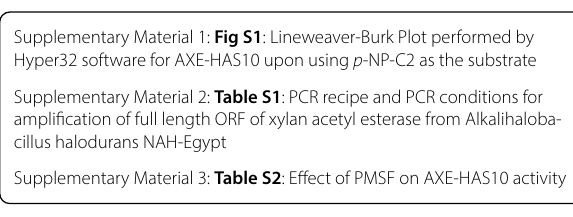
Supplementary Material 3: Table S2 : Effect of PMSF on AXE-HAS10